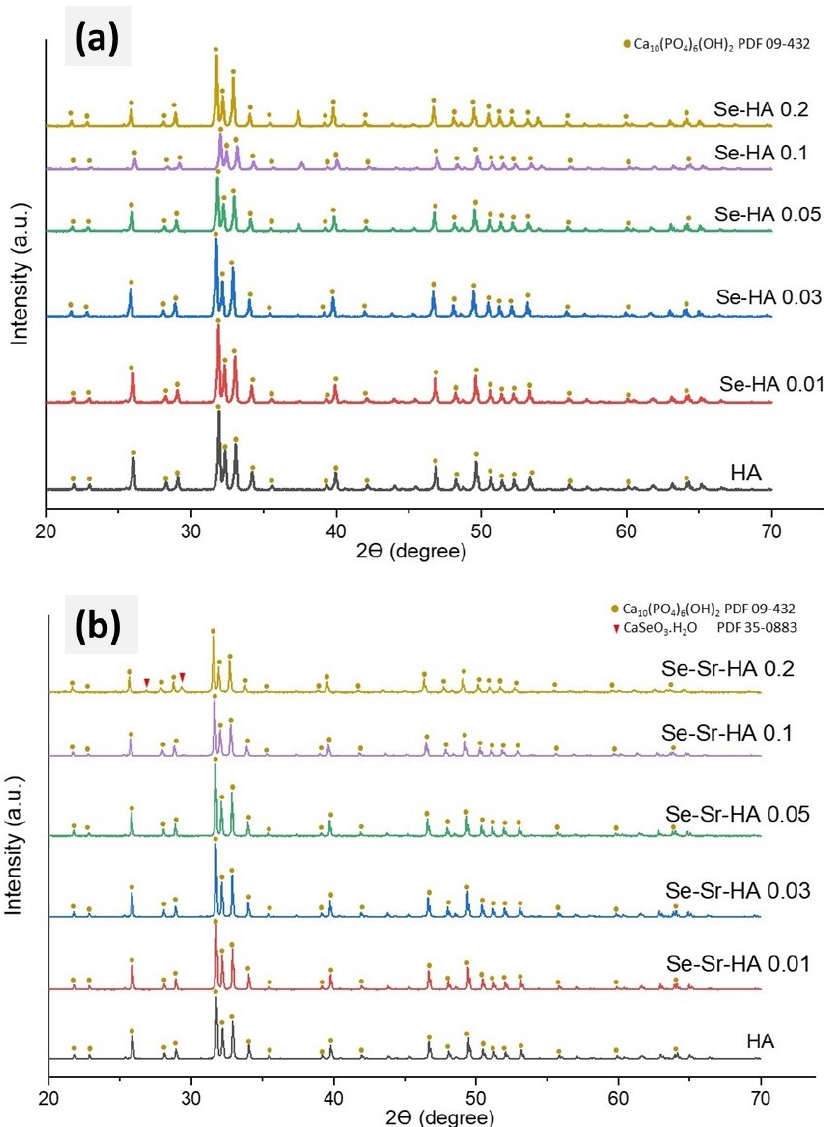
Figure 1. XRD patterns of selenium-substituted hydroxyapatite (Se-HA) ( a ) and selenium and strontium-substituted hydroxyapatites (Se-Sr-HA) with different Se and Se/Sr molar ratios ( b ) sintered at 900 ◦